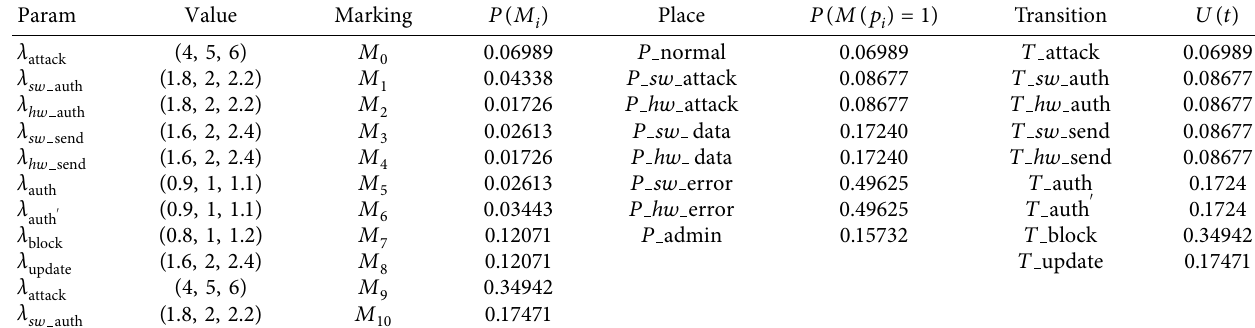
Table 5: Calculation results of the SPN